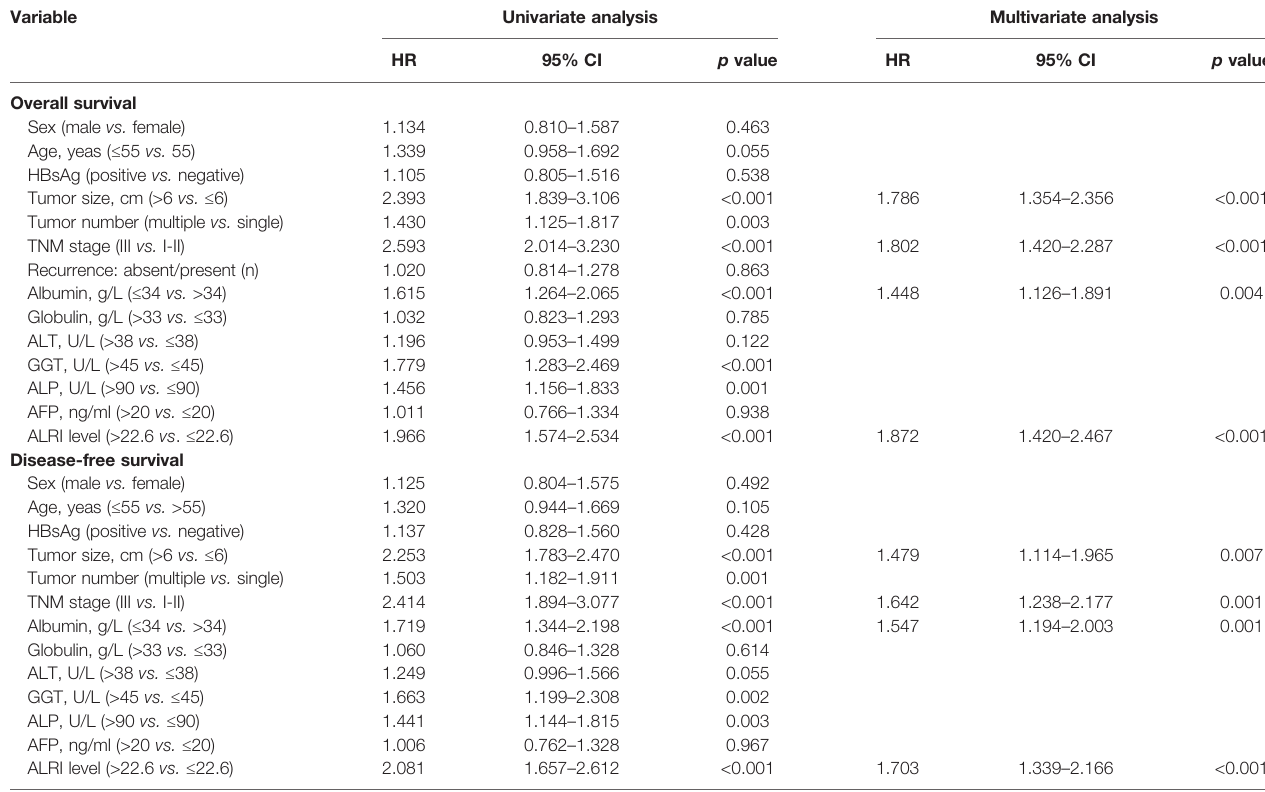
TABLE 2 | Univariate and multivariate Cox regression analyses of the clinicopathologic characteristics for OS and DFS in training cohort with HCC. Variable Univariate analysis Multivariate analysis HR 95% CI p value HR 95% CI p value Overall survival Sex (male vs.